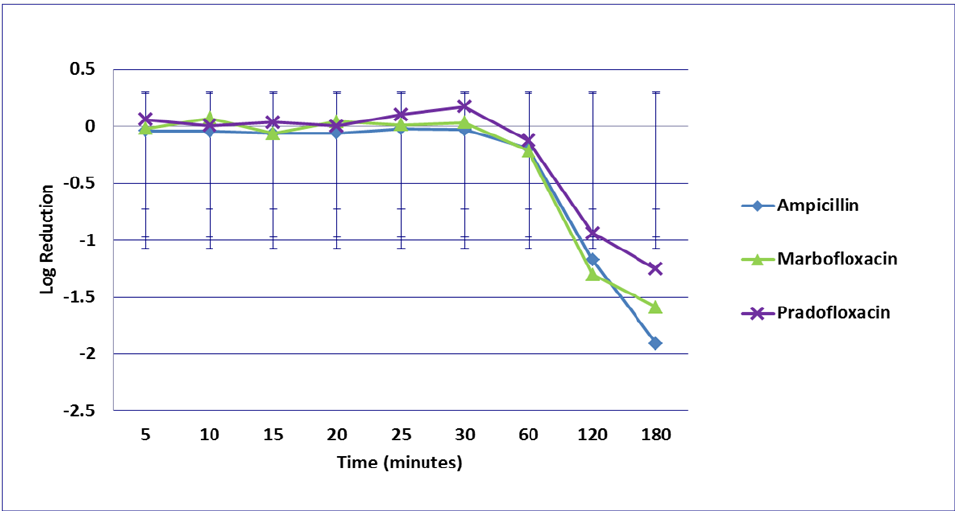
Figure 6. Log 10 reduction in E. faecalis with bacterial cells exposed to ampicillin, marbofloxacin, and pradofloxacin at the mutant prevention drug concentration. Data points present mean ± standard deviation.